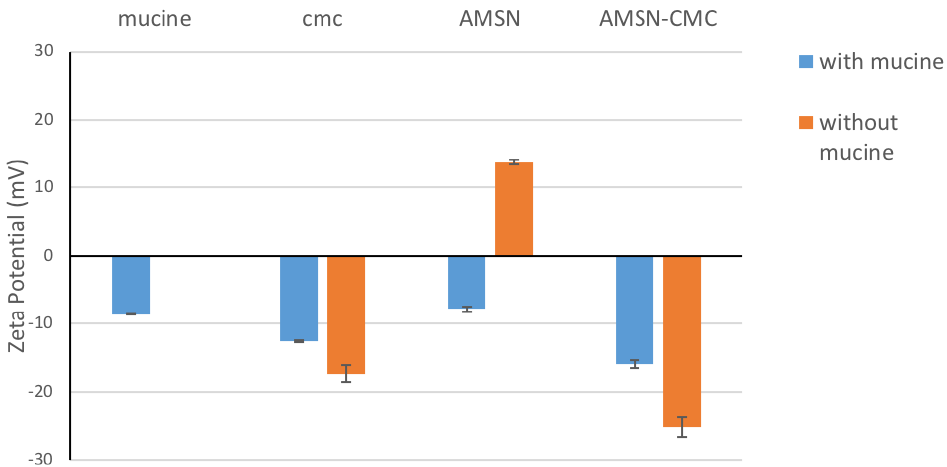
Figure 7. Change in the zeta potential of AMSN and AMSN-CMC nanoparticles after incubation with mucin. with